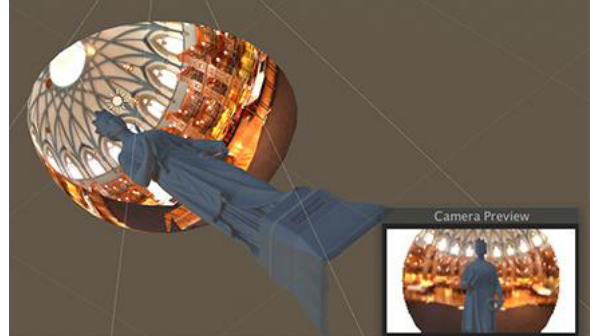
Figure 5. Panoramic image remapped in the hemisphere.